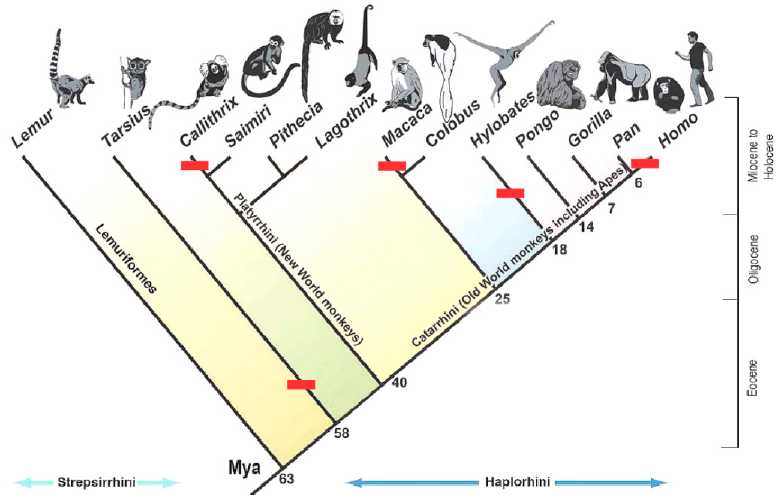
Figure 4. Cladogram showing the appearance and pattern of phylogenetic inheritance for muscles identified as potentially homologous with M sternalis in humans. Red bars indicate the branch on which the character state (presence of M sternalis or homologous muscle) appears. Data used for the character states described in Table 3. Image source: Available under Creative Commons Licensing from https://upload.wikimedia.org/wikipedia/en/thumb/f/f0/PrimateTree2.jpg/1280px-PrimateTree2.jpg.